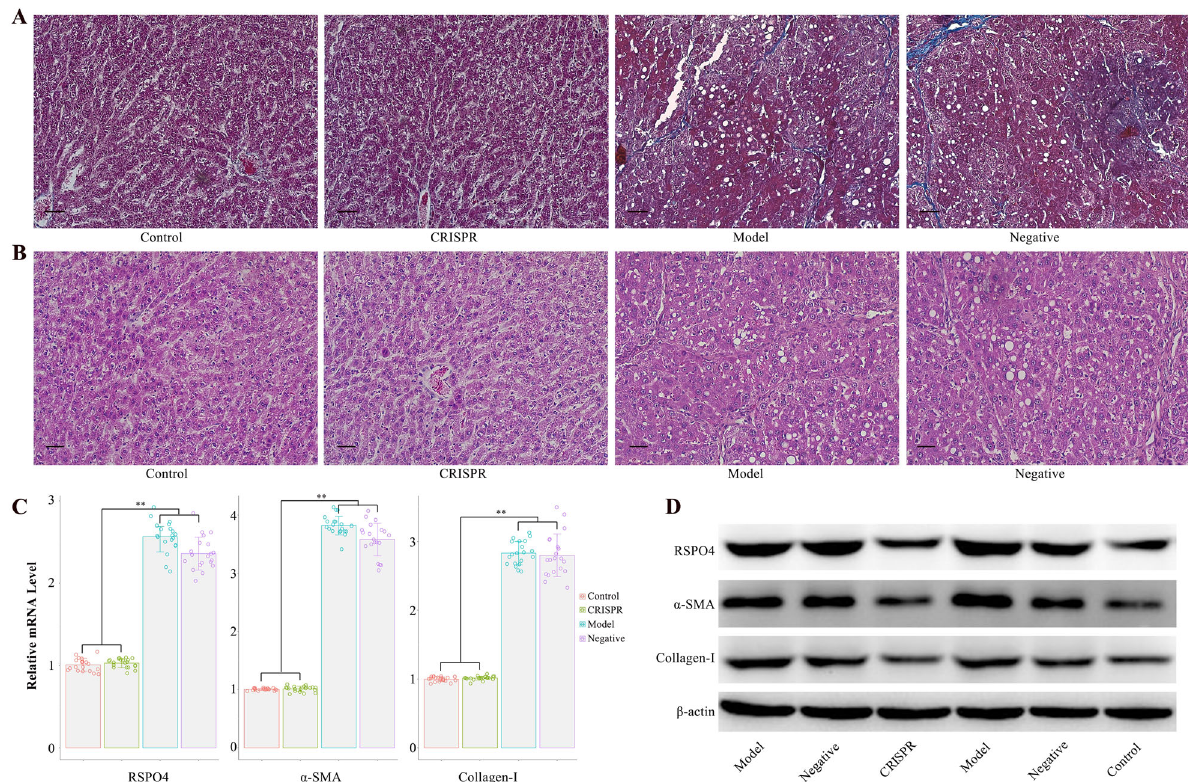
Fig. 1 RSPO4-CRISPR relieve hepatic fi brosis in a rat model of CCl 4 -induced liver fi brosis. A Masson staining indicated the restoration of hepatic fi brosis in the CRISPR group (bar 50 μ m, magni fi cation ×200). B HE staining showed decreased vacuoles degeneration of hepatocytes in the CRISPR group (bar 50 μ m, magni fi cation ×200). C the mRNA level of RSPO4, α -SMA, and collagen-I in CRISPR group were signi fi cantly lower than the model group and were close to those of the control. D Western blot assay showed the protein expression of RSPO4, α -SMA, and Collagen-I in the CRISPR group were signi fi cantly lower than the model group and were close to those of the control. The CCl 4 -induced liver- fi brotic rats were noted as the model group, and the rats in the model group transfected with RSPO4-CRISPR were noted as the CRISRP group. Data represent the mean of three independent experiments, and error bars are the standard deviation of means. * p < 0.05 compared with the control, ** p < 0.01 compared with the